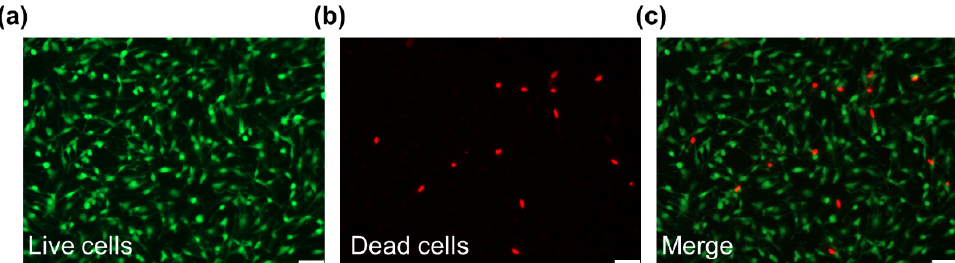
Figure 9. Live/dead staining images of SCs seeded on chitin film. ( a ) The live SCs were labeled with Calcein-AM (green). ( b ) The dead SCs were labeled with PI (red). ( c ) Merged image of live/dead staining. Scale bar = 50 µm.